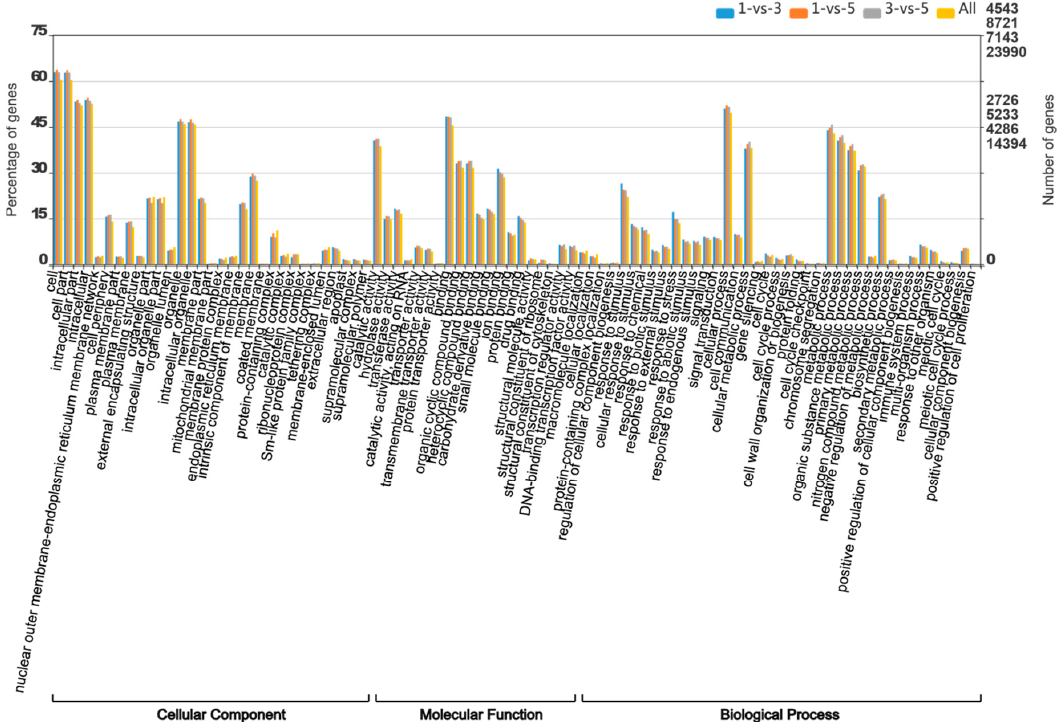
Figure 5. Three main categories in the Gene Ontology (GO) classification database.